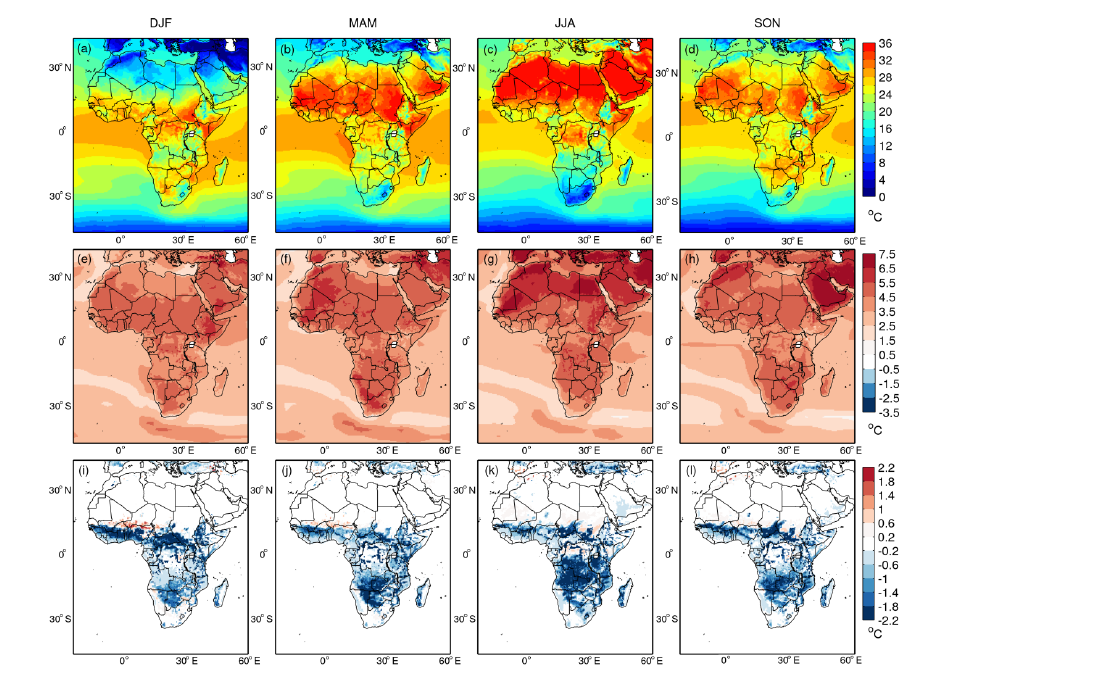
Figure A3. Simulated seasonal surface temperature for present day (a–d) , for changes in future in the NFB experiment ( e–h , future minus present day), and for changes from vegetation feedback in future ( i–l , FB minus NFB for future). Definitions for calculation period, climate change signal and vegetation feedbacks are given in Sect. 2.2.